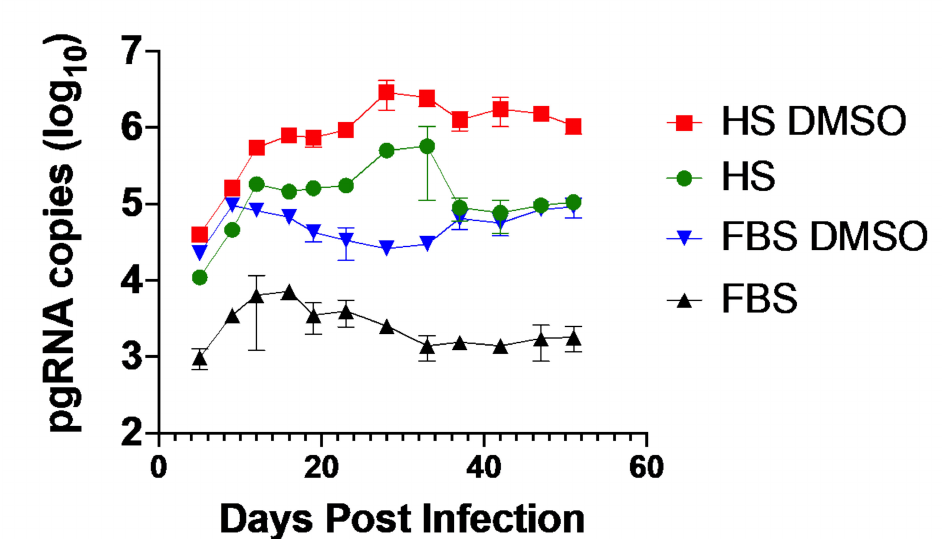
Figure 3. Sustained infection by HBV in Huh7.5-NTCP cells cultured in human serum. Huh7.5-NTCP cells cultured in the medium supplemented with FBS or HS were infected with 500 genome equivalents per cell with or without 2% DMSO during infection. HBV pgRNA in the cells was repeatedly measured using RT-qPCR every 4–5 days for 50 days after HBV infection. Average values with error bars ( ± SD) derived from three experiments are